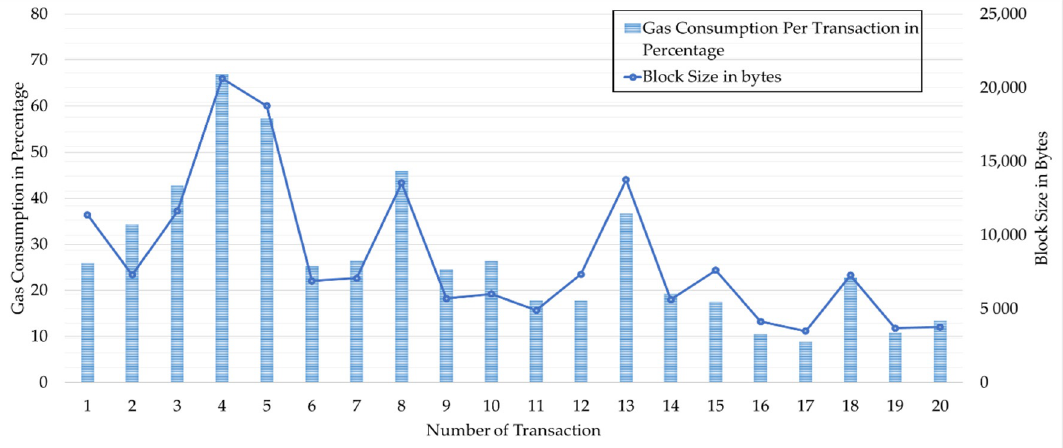
Figure 12. Gas Consumption and Block Size versus Number of Transaction of the PCAC-SC functions.